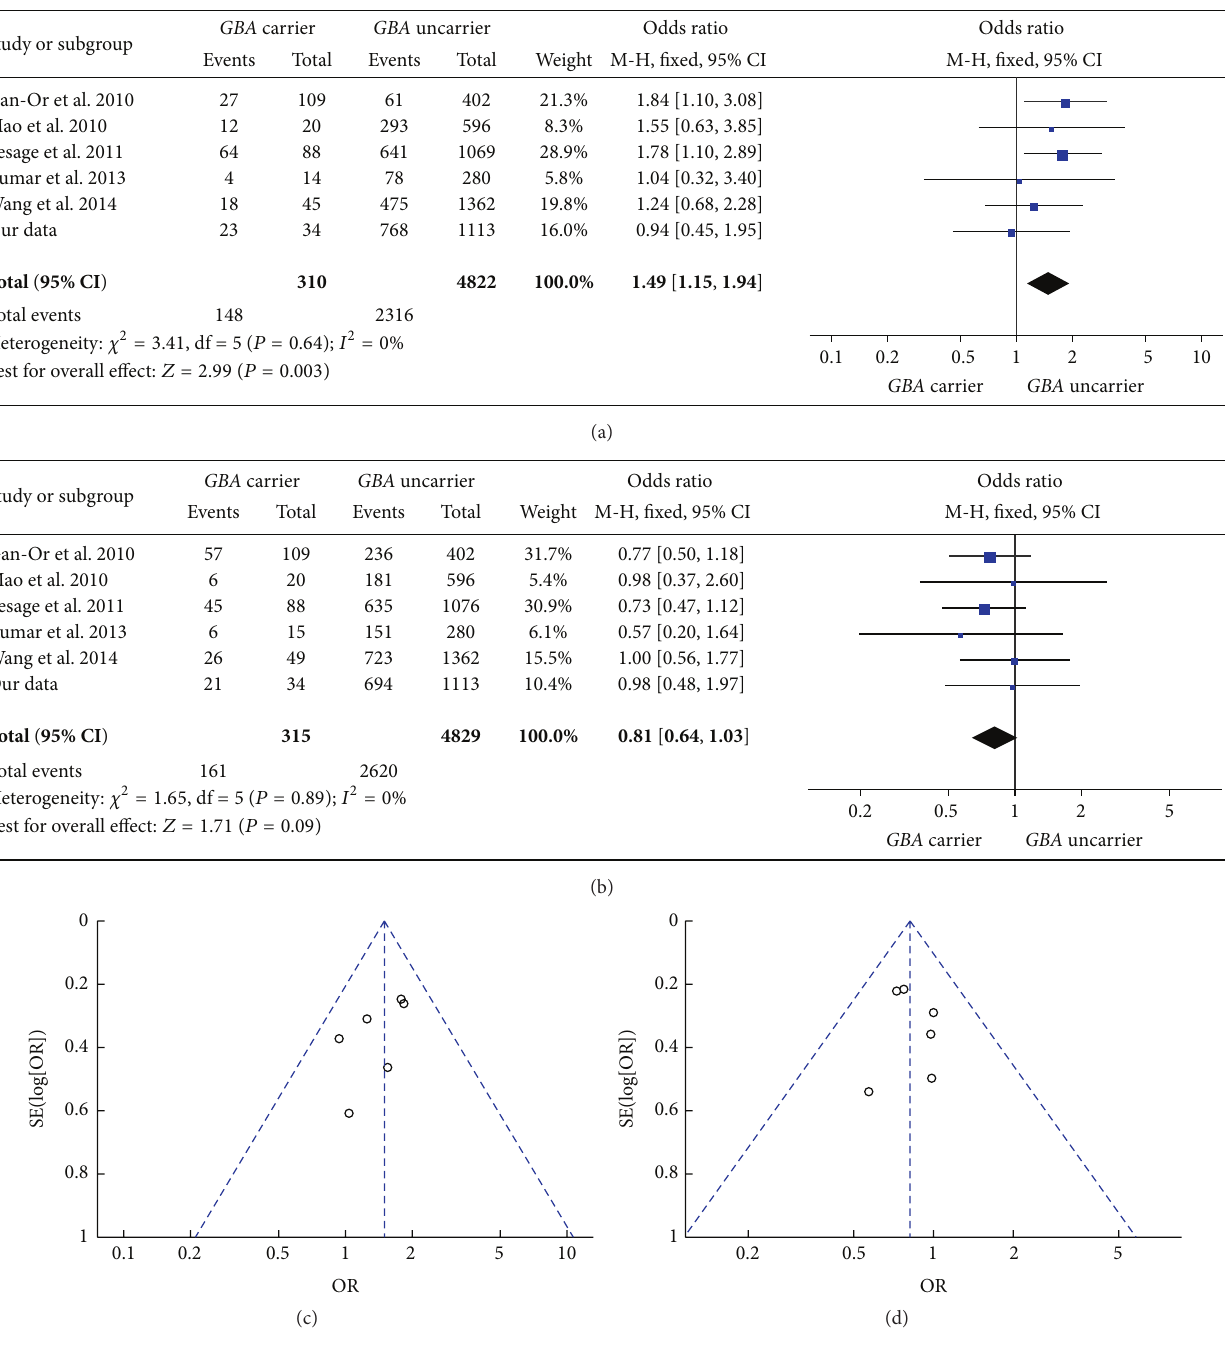
Figure 4: (a) Forest plot of bradykinesia as an initial symptom in GBA + PD and GBA − PD. (b) Forest plot of tremor as an initial symptom in GBA + PD and GBA − PD. (c) Funnel plot of bradykinesia as an initial symptom in GBA + PD and GBA − PD. (d) Funnel plot of tremor as an initial symptom in GBA + PD and GBA −